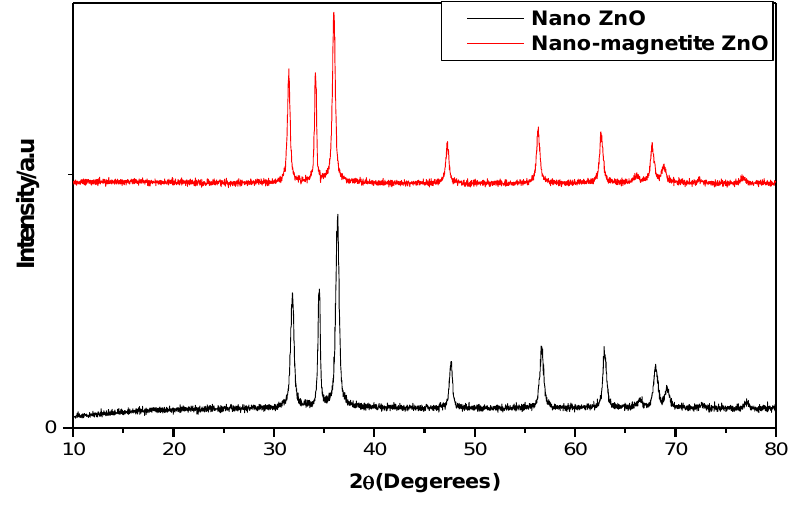
Figure 1. X-ray diffraction (XRD) patterns for pure ZnO nanotubes and magnetic ZnO nanotubes.